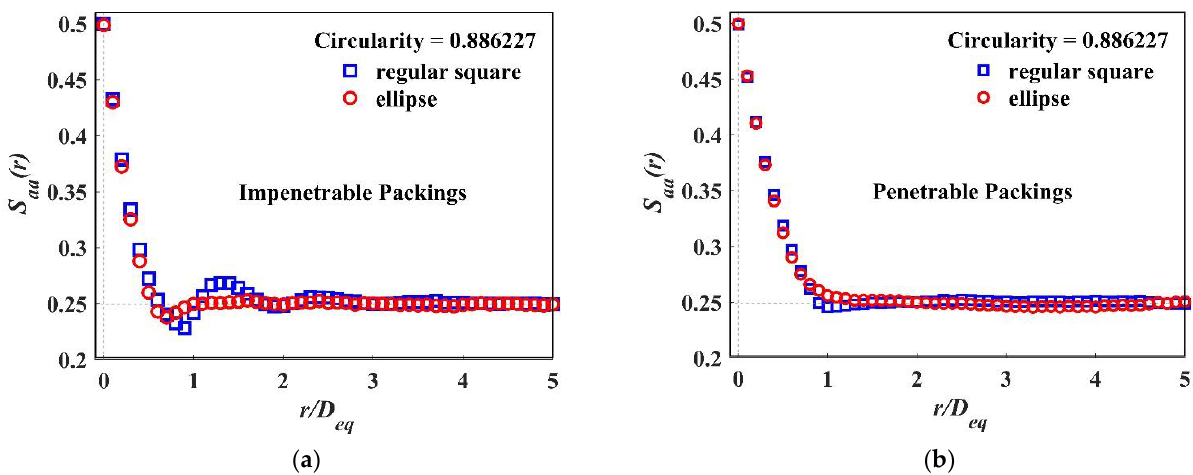
Figure 9. 𝑆 𝑎𝑎 (𝑟) of different particle packing systems with the same circularity and the same pack- ing fraction 𝜙 𝑎 = 0.5 : ( a ) Impenetrable packing system of regular square and ellipse; ( b ) Penetrable packing system of regular square and ellipse.